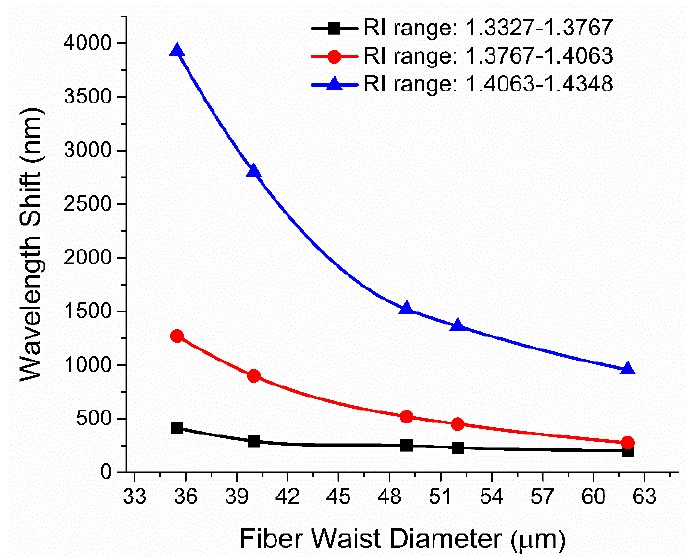
Figure 10. The relation between spectral wavelength shift and fiber waist diameter for various microfiber MZIs with different TWDS.